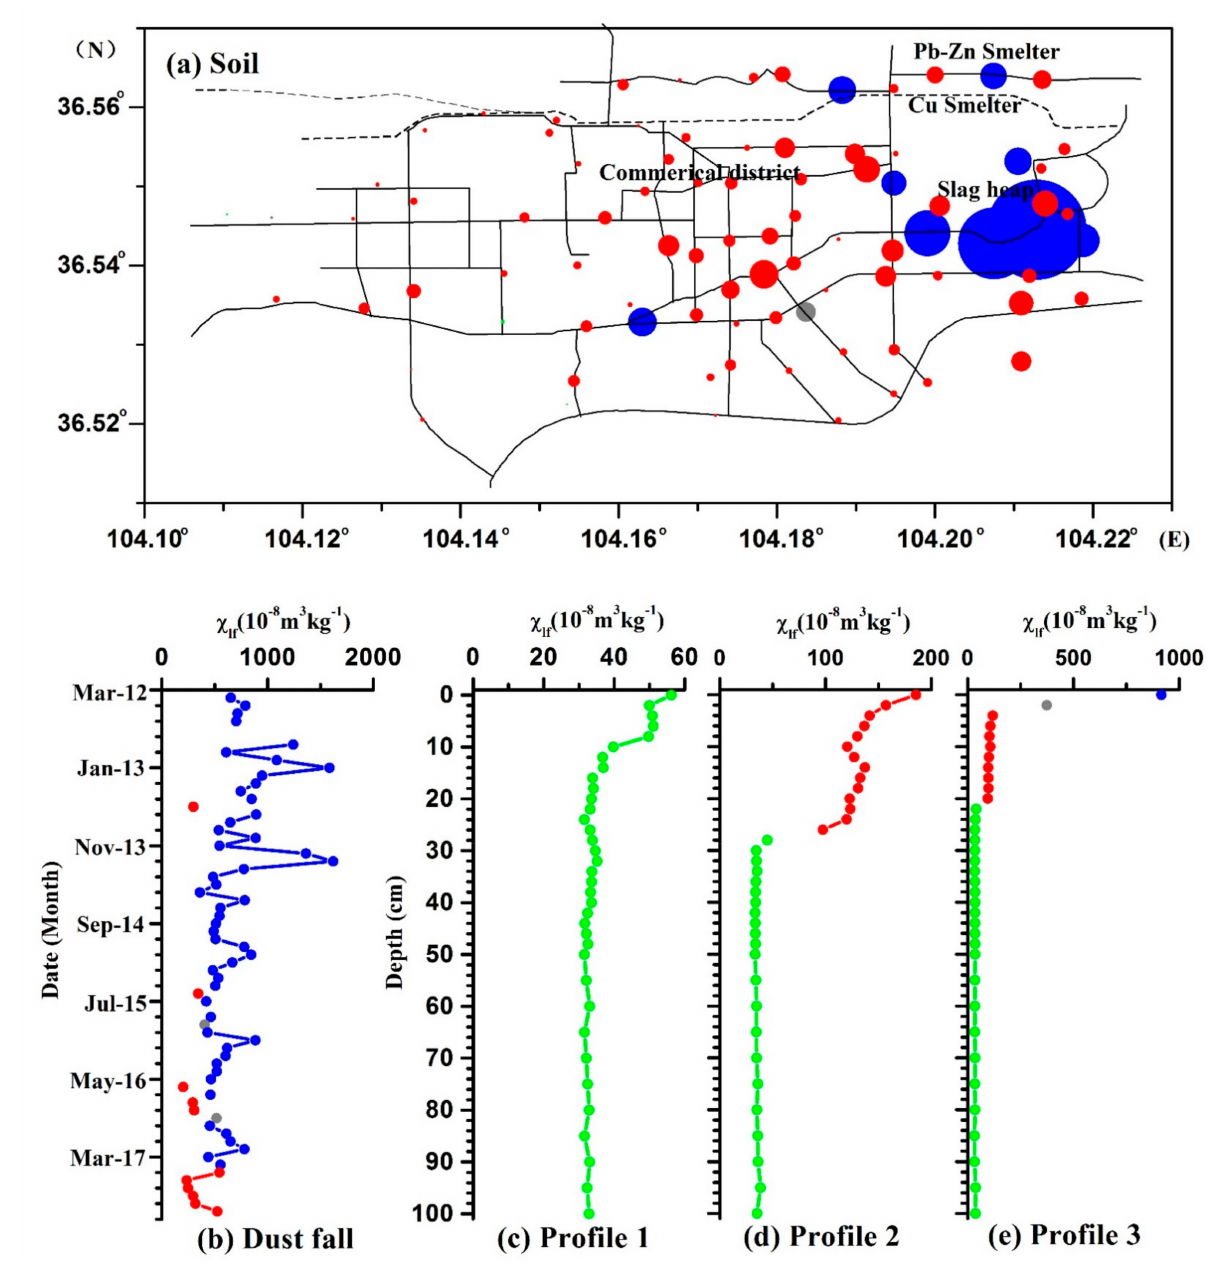
Figure 9. Spatial distribution of the degree of affinity of each sample to each of its possible (fuzzy) clusters. ( a ) topsoil; ( b ) atmospheric dustfall; ( c ) soil profile 1; ( d ) soil profile 2; ( e ) soil profile 3. Green dots represent samples of cluster 1, red dots samples of cluster 2, and blue dots samples of cluster